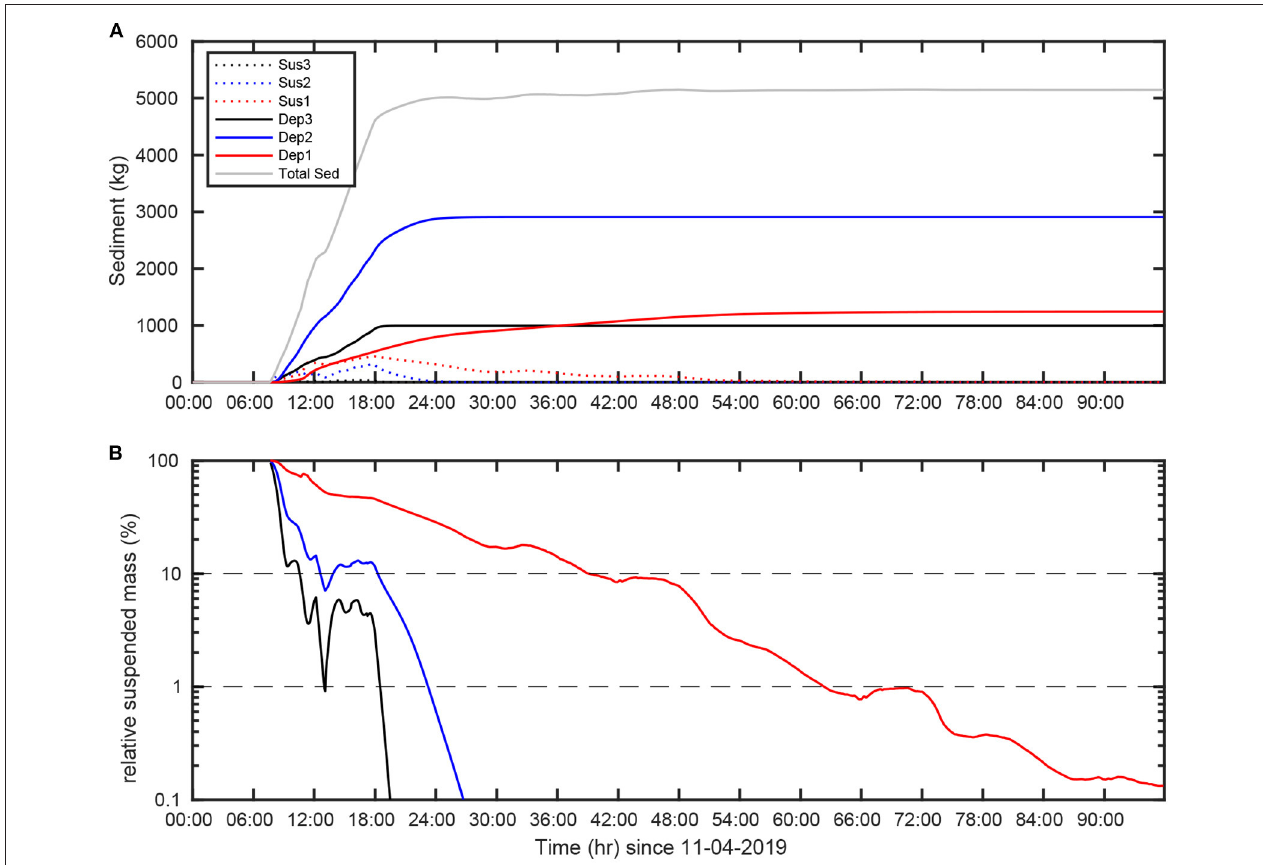
FIGURE 9 | (A) Mass balance for total sediment release (solid grey line), deposited mass (solid colour lines) and suspended mass (dotted lines) in the entire area of simulation for each class for 4 days of simulation. Black, blue, and red colour lines refer to sediment class 1, class 2, and class 3, respectively. (B) Time evolution of relative suspended mass in the water for the given sediment class in percent. The y-axis is in logarithmic scale.